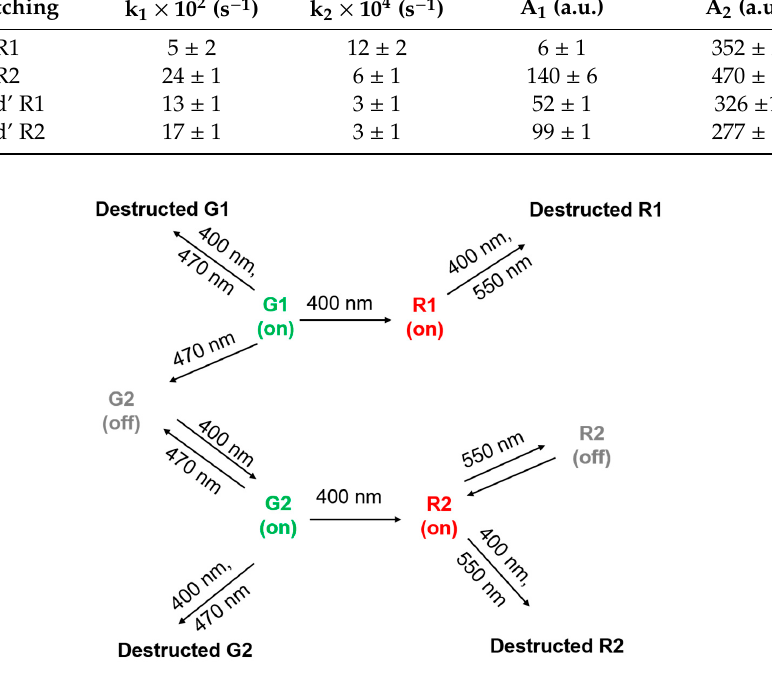
Figure 5. Absorbance spectra of R2 SAASoti ( A ) before (red line) and after 50 s 550 nm exposure (grey line). ( B ) The subtraction of initial R2 absorbance spectrum from the 550 nm (50 s) exposed protein spectrum. Table 2. Kinetic parameters in the reaction of ‘on’-‘o ff ’-switching of red SAASoti forms ( ± S.E.).